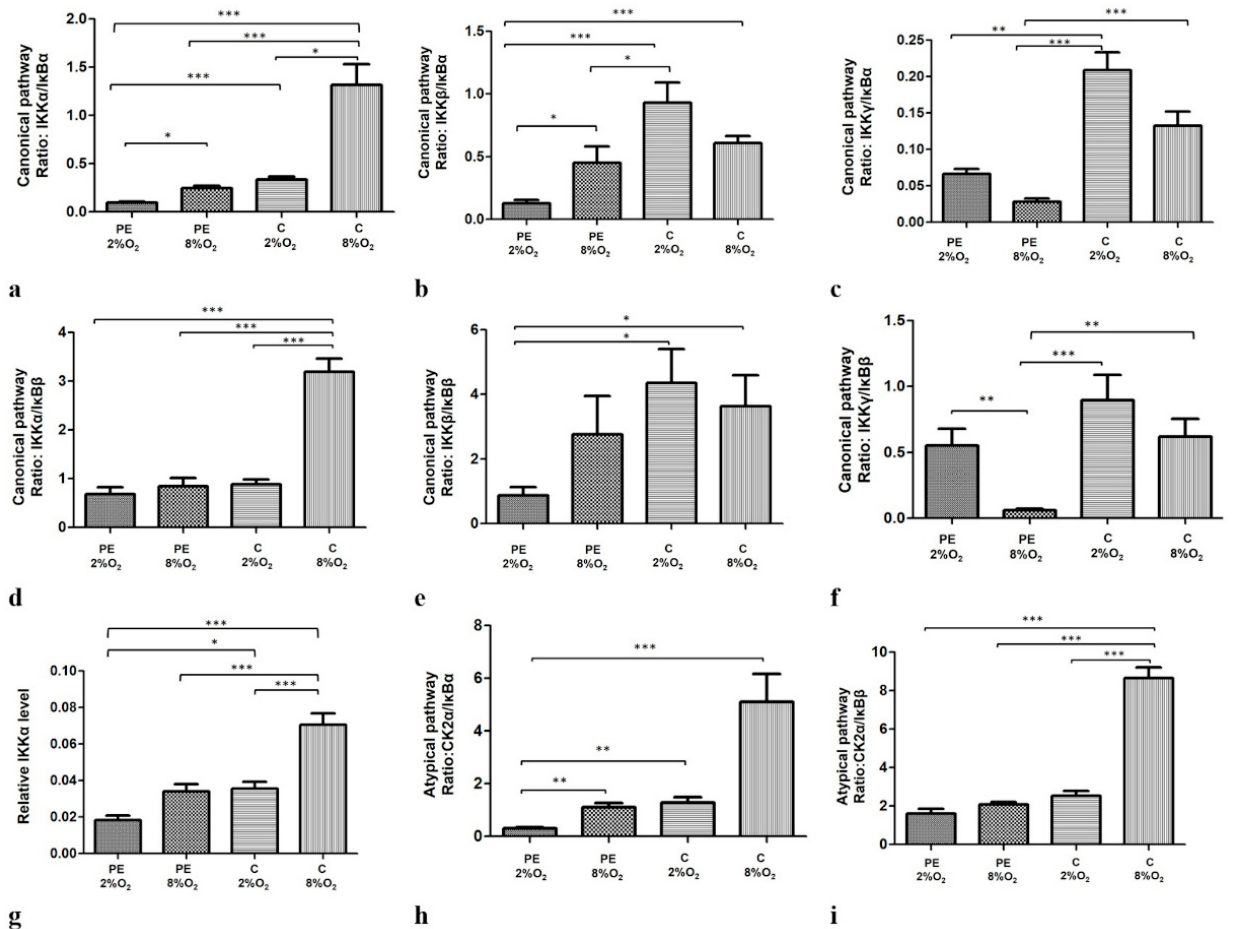
Figure 2. Comparison of the efficiency of the canonical ( a – f ), non-canonical ( g ) and atypical ( h , i ) NF κ B activation pathways. Each profile was calculated based on the ratio of one of the activators to one of the NFkB inhibitors in the studied pathway; however, the non-canonical pathway was calculated based only on IKK α protein level. The data are presented as mean ± SEM ( n = 3 experiments), p -value calculated by ANOVA with the Bonferroni post hoc test or Kruskal–Wallis with Dunn’s post hoc test, depending the data distribution. * p < 0.05; ** p < 0.01, *** p < 0.001.